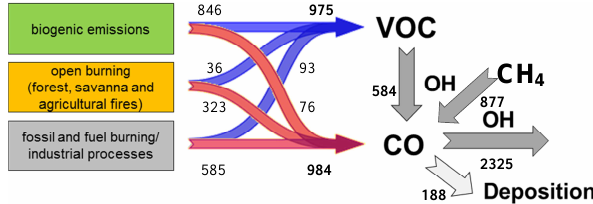
Figure 1. The global CO budget: sources and sinks. Numbers are in teragrams per year as estimated from this study using MACC- ity/MEGAN/GFAS emissions for the year